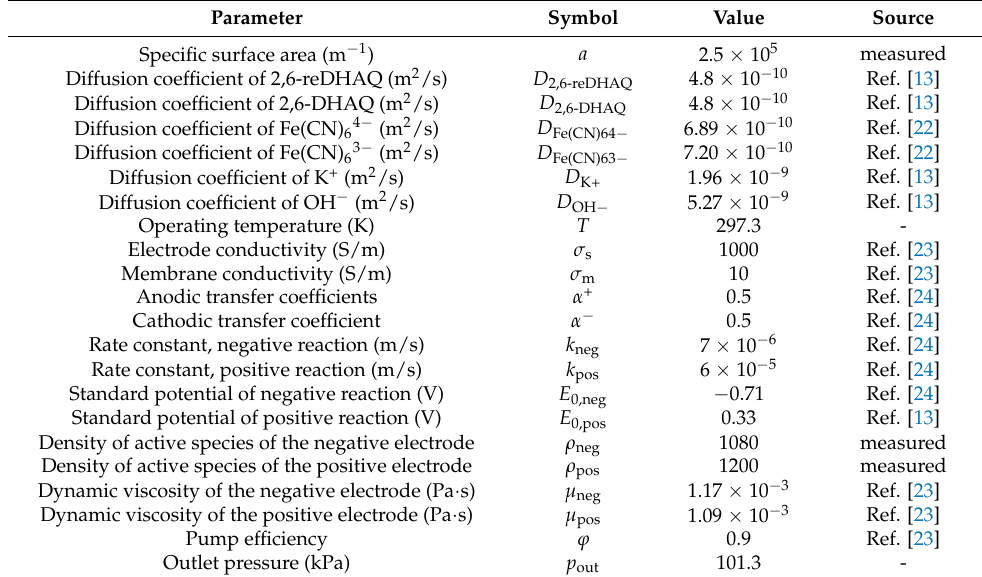
Table 1. Kinetic and electrochemistry parameters used in the simulation. Parameter Symbol Value Source Specific surface area (m − 1